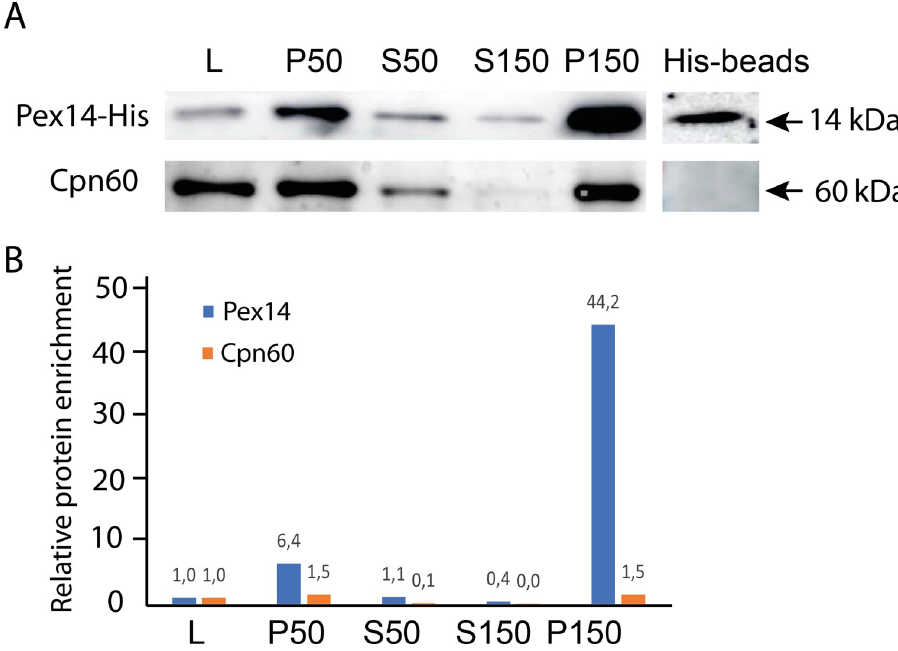
Fig 8. Affinity purification of peroxisomes. A. Lysate of cells (L) expressing His-tagged Pex14 was used for differential centrifugation at 50 000 and 150 000 x g, and pellet (P) and soluble (S) fractions were analyzed by western blotting. In the last step, peroxisomes were purified using anti-His antibody-conjugated beads (His-beads) that were used for mass spectrometry. Antibodies against Cpn60 were used as mitosomal markers. B. Relative protein enrichment was calculated with densitometry of Pex14-His and Cpn60 signals.